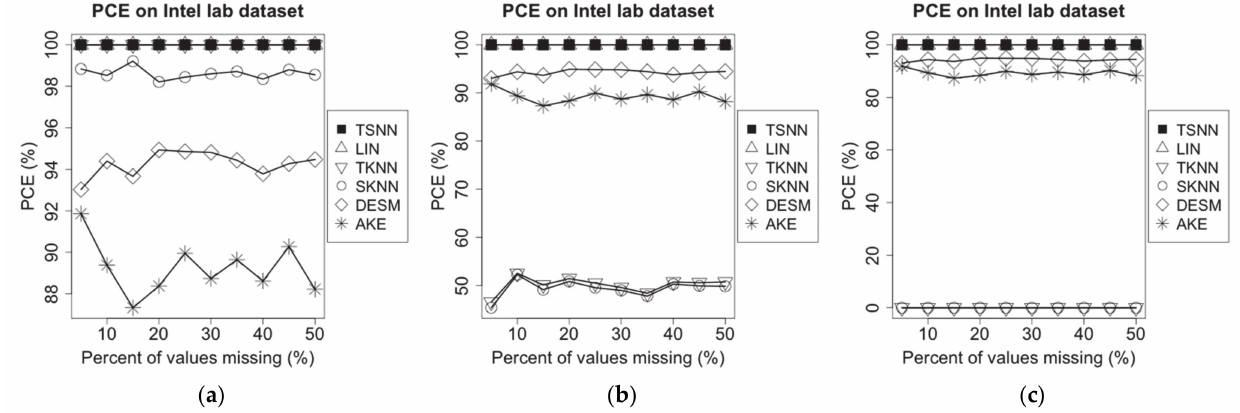
Figure 5. PCE of different algorithms on Intel lab dataset for the three scenarios: ( a ) temperature NA and humidity not NA, ( b ) temperature NA and humidity 50% NA and ( c ) temperature NA and humidity NA. On GreenOrbs dataset, the same experiments have been made, and the results are shown in Figure 6.